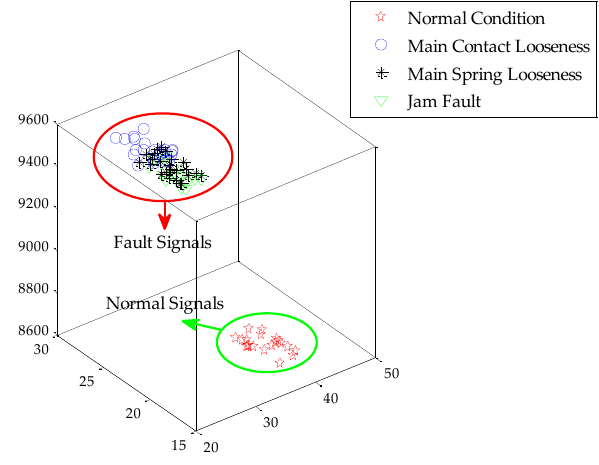
Figure 10. Distribution of weight divergence under different conditions.